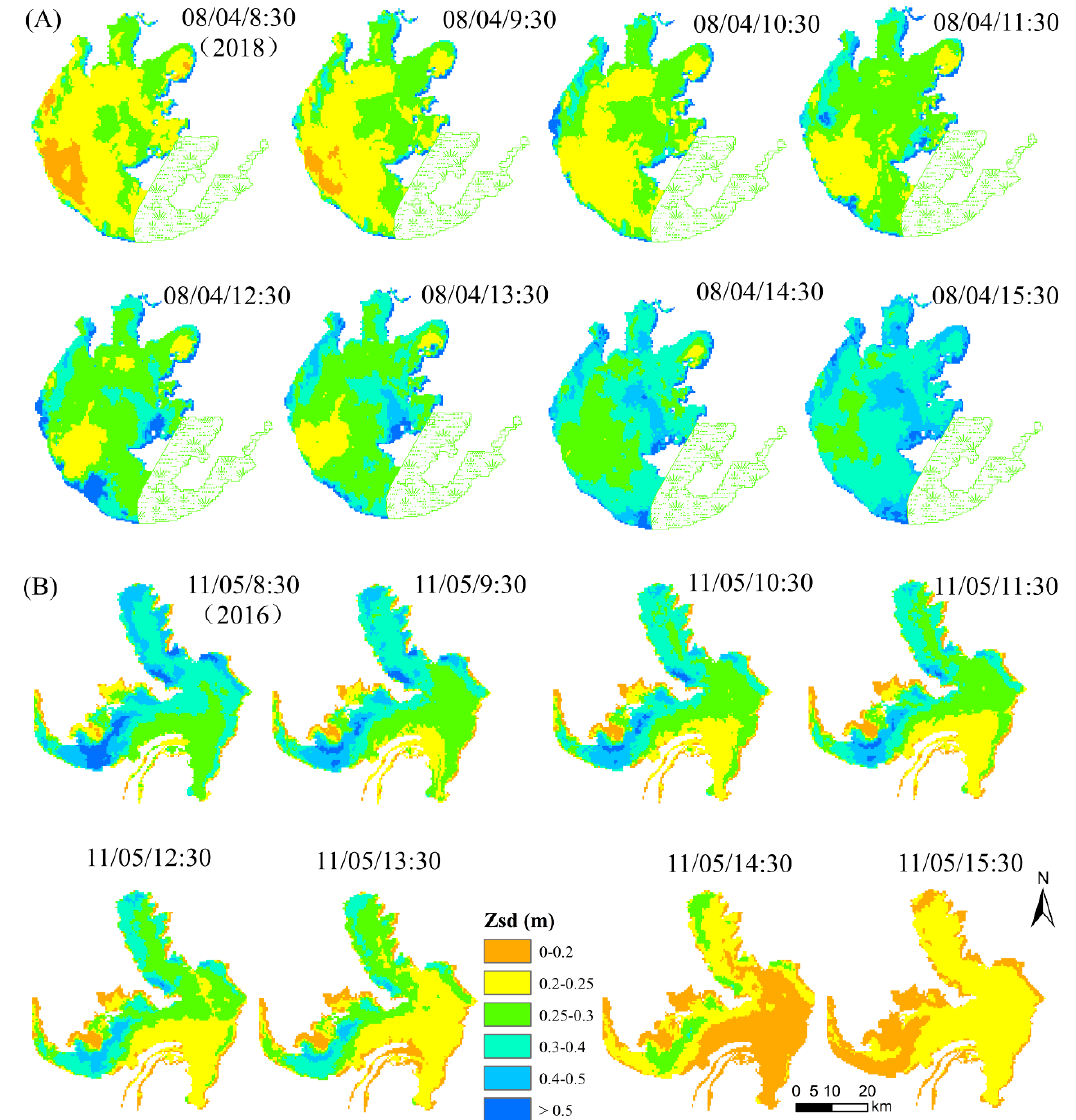
Figure 6. Hourly variations of GOCI-derived Z SD based on Z SDZ model in Lake Taihu ( A ) and Lake Hongze ( B ). The retrieval results of Z SD in the eastern part of Lake Taihu are not shown due to the dense distribution of aquatic vegetation (see Figure 1).